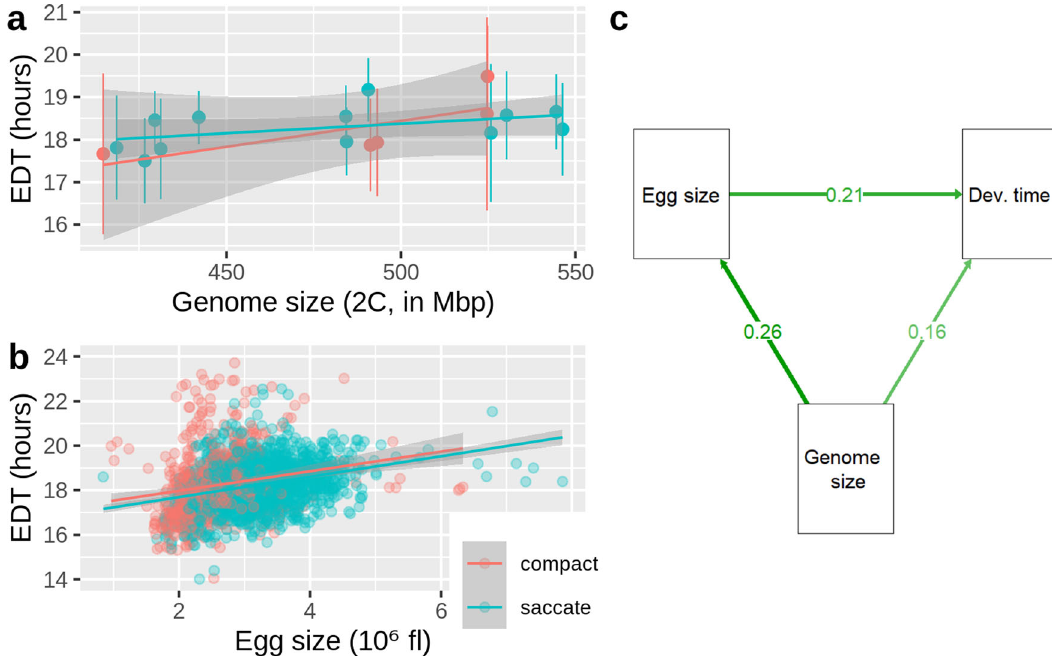
Fig. 2 Relationship between genome size on embryonic development time (EDT). a Genome size in 17 clones of the OHJ-population is positively correlated with average EDT. Shaded regions are the 95% con fi dence intervals. b Correlation between egg size and EDT, based on measurements of 2010 amictic eggs (Supplementary Data 3). c Path diagram showing direct and indirect effects (i.e., via egg size) of genome size on embryonic development time. The results of the underlying structural equation model are displayed in Supplementary Table 1. Source data of this fi gure are provided in Supplementary Data 3.